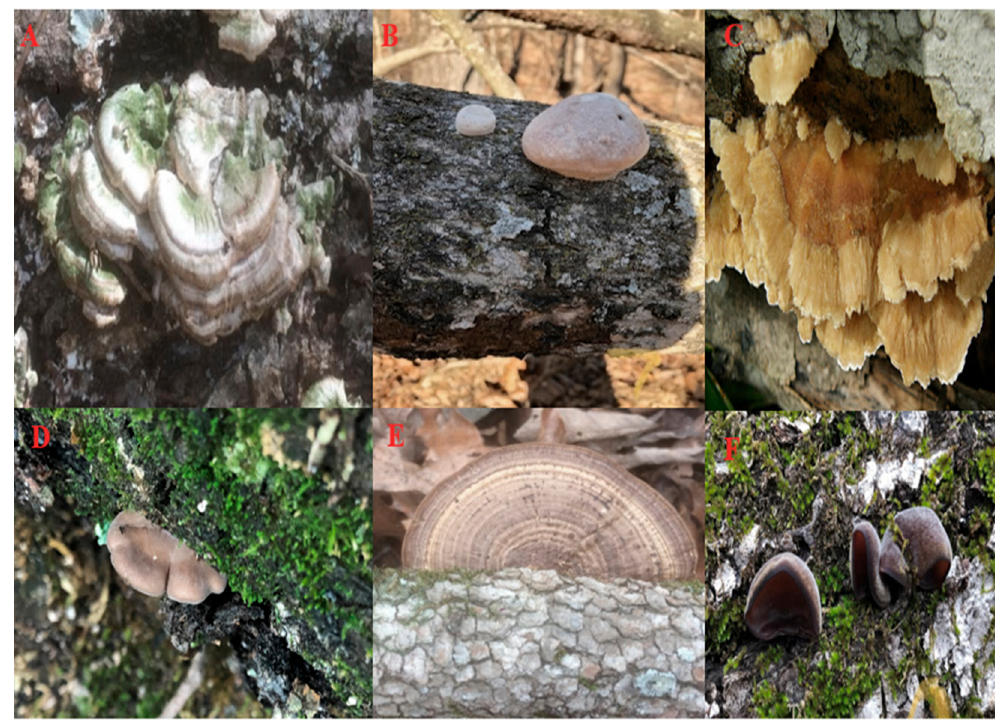
Figure 2. Selected species of wood-decay fungi documented from Northwest Arkansas. ( A ) Trichaptum biforme , ( B ) Trametes elegans , ( C ) Trametopsis cervina , ( D ) Panellus stipticus , ( E ) Daedaleopsis confragosa , and ( F ) Auricularia americana .